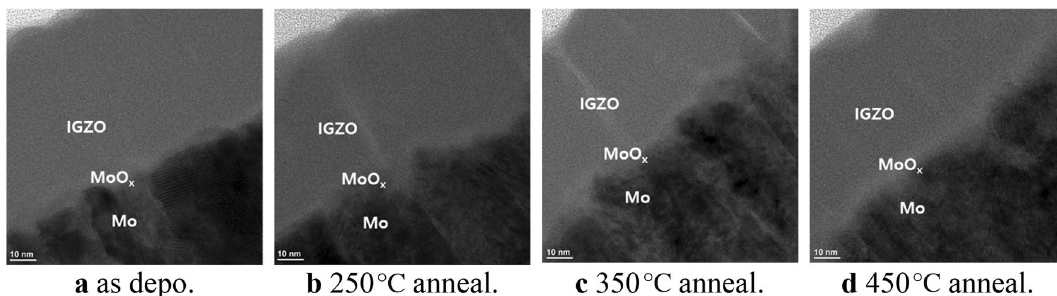
Figure 2. HR-TEM of Mo-IGZO interface for various annealing temperatures.